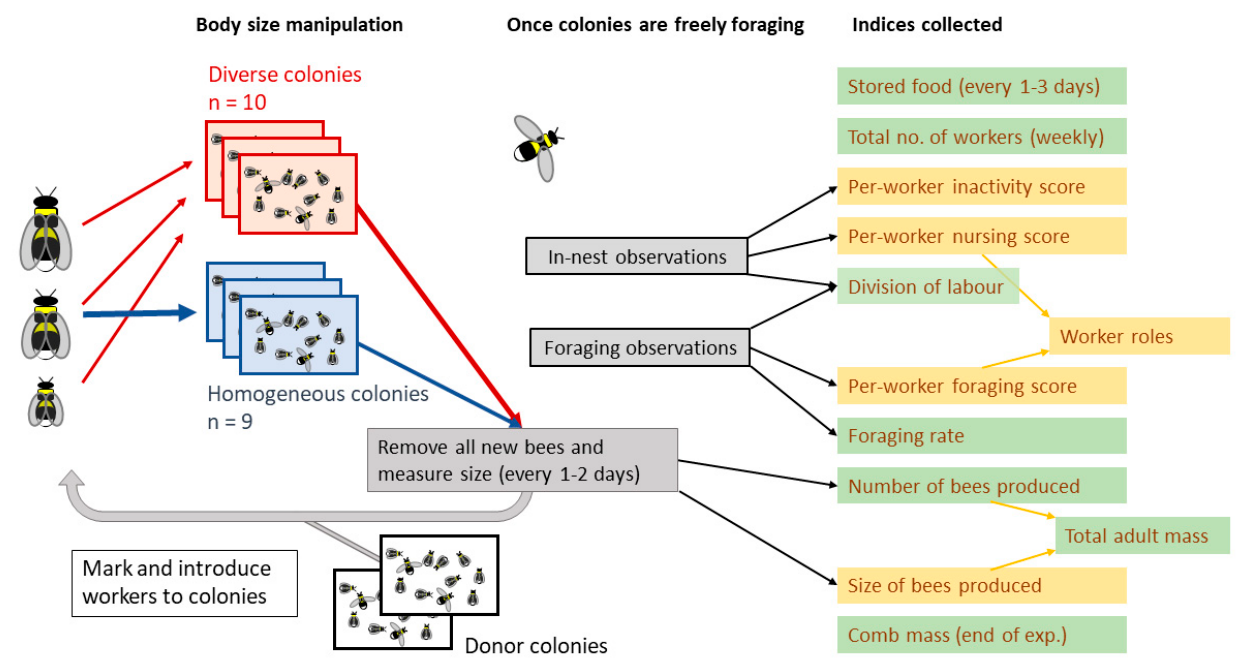
Figure 1. Experimental design summary. Lab colonies of Bombus terrestris were continuously manipulated over approx- imately two months, with all new workers redistributed according to body size to maintain either diverse (all sizes) or homogeneous (only medium size) distributions. After an initial establishment period, colonies were allowed to freely forage in the natural environment. Behavioural observations and other assessments were used to produce a number of individual-level indices (yellow boxes) and colony-level indices (green boxes) which were used for assessing behaviour and colony performance in downstream analyses.